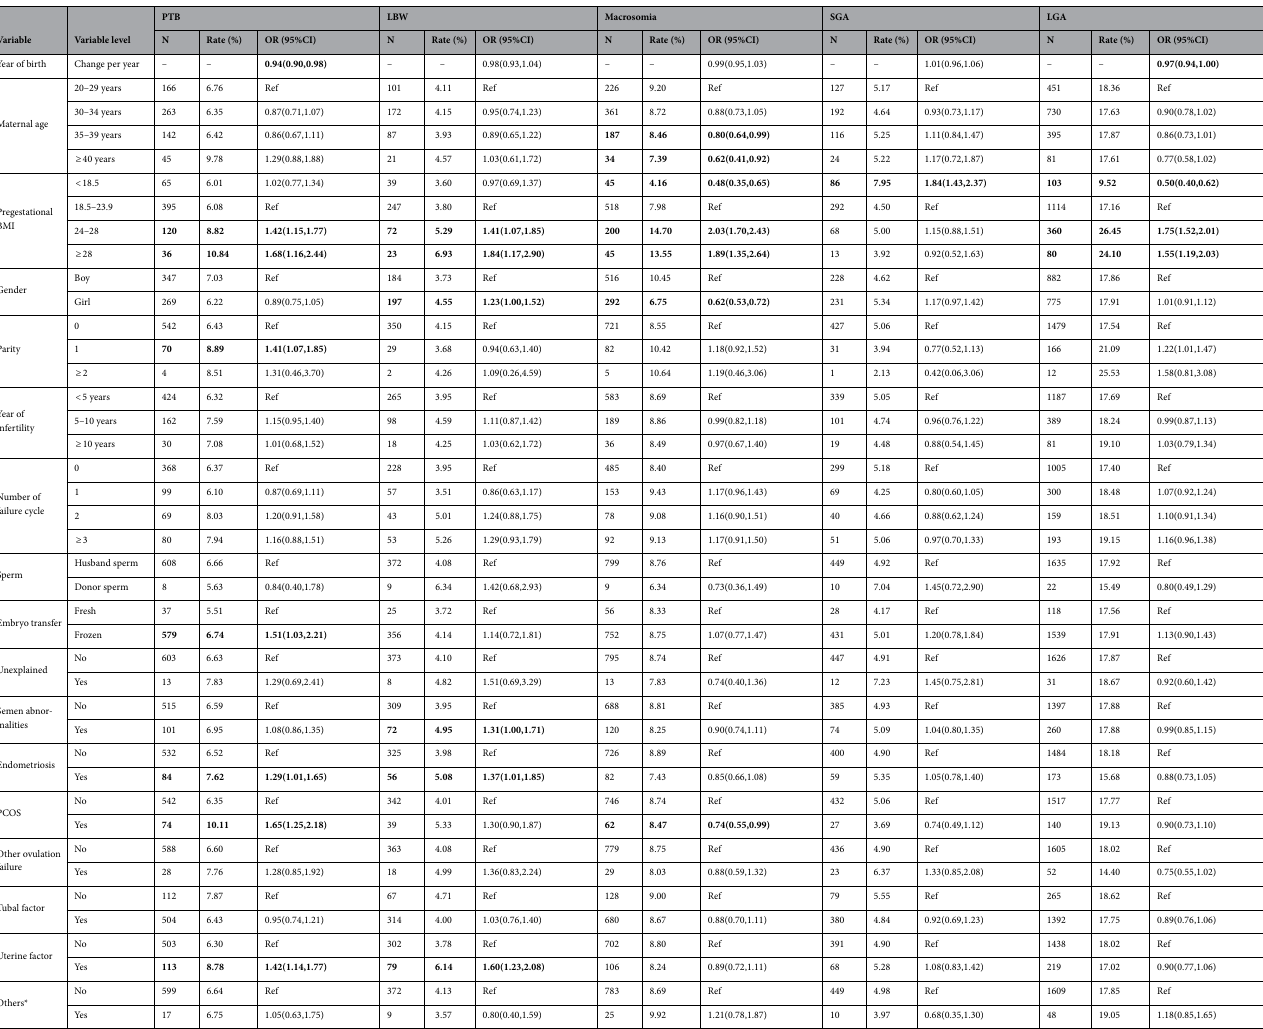
Table 2. Risk factors of adverse birth outcomes in singletons conceived with IVF. *Others: including chromosomal abnormality, immune factors, pituitary lesions and sexual dysfunction. Statistical differences are shown in